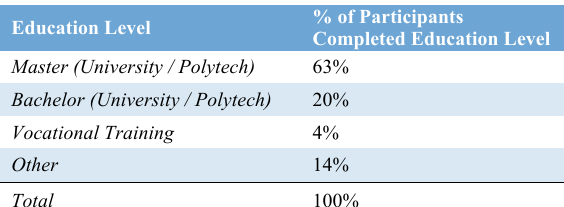
Table 3. Participant’s highest completed education level.